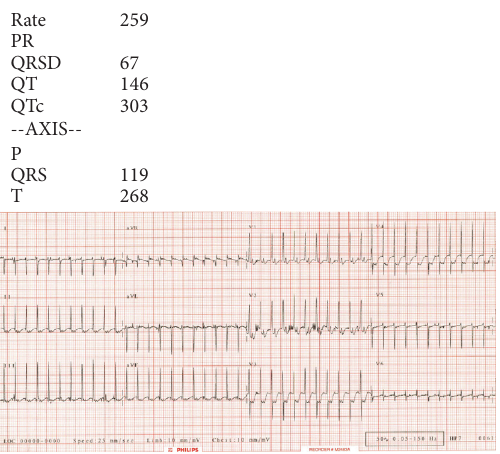
Figure 1: Initial postinsertion CXR, showing appropriate UVC placement, just below the diaphragm at T9.